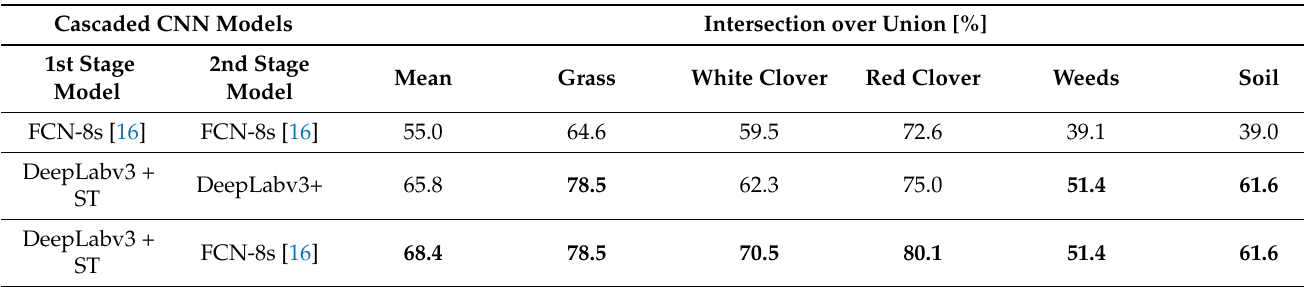
Table 3. Mean and per class Intersection over Union for semantic segmentation on the GrassClover test set on the evaluation server. The baseline result is provided by the two hierarchically trained FCN-8s models [12]. ST represents the additional fine-tuning on style-transfer augmented image samples. The best result in each category is marked in bold